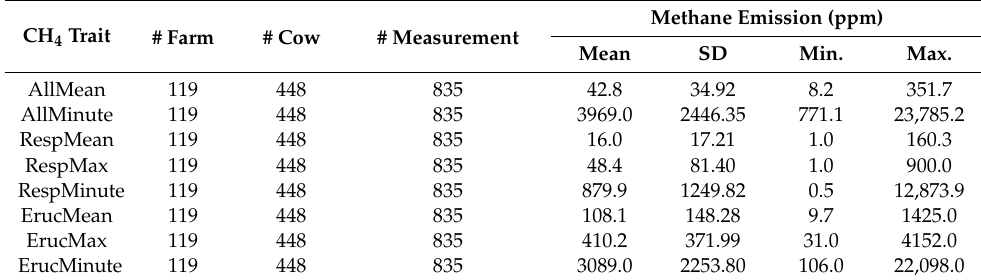
Table 2. Descriptive statistics of the defined methane emission